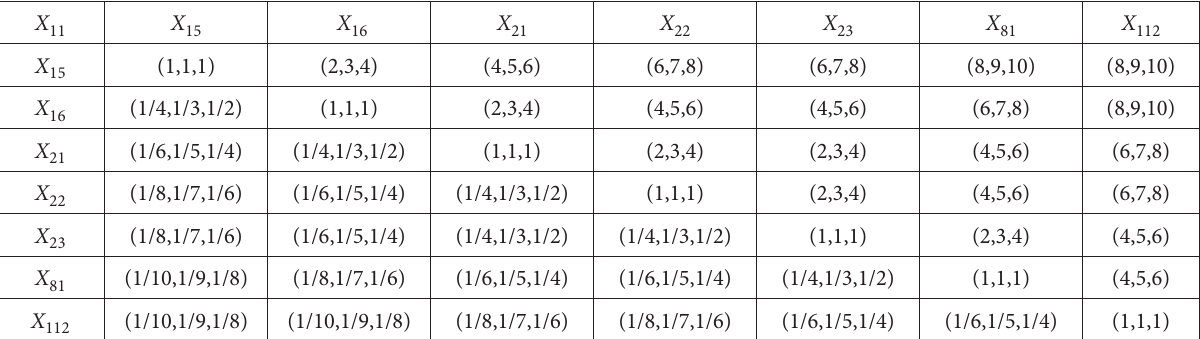
Table 7. Pair-wise comparison with fuzzy scale